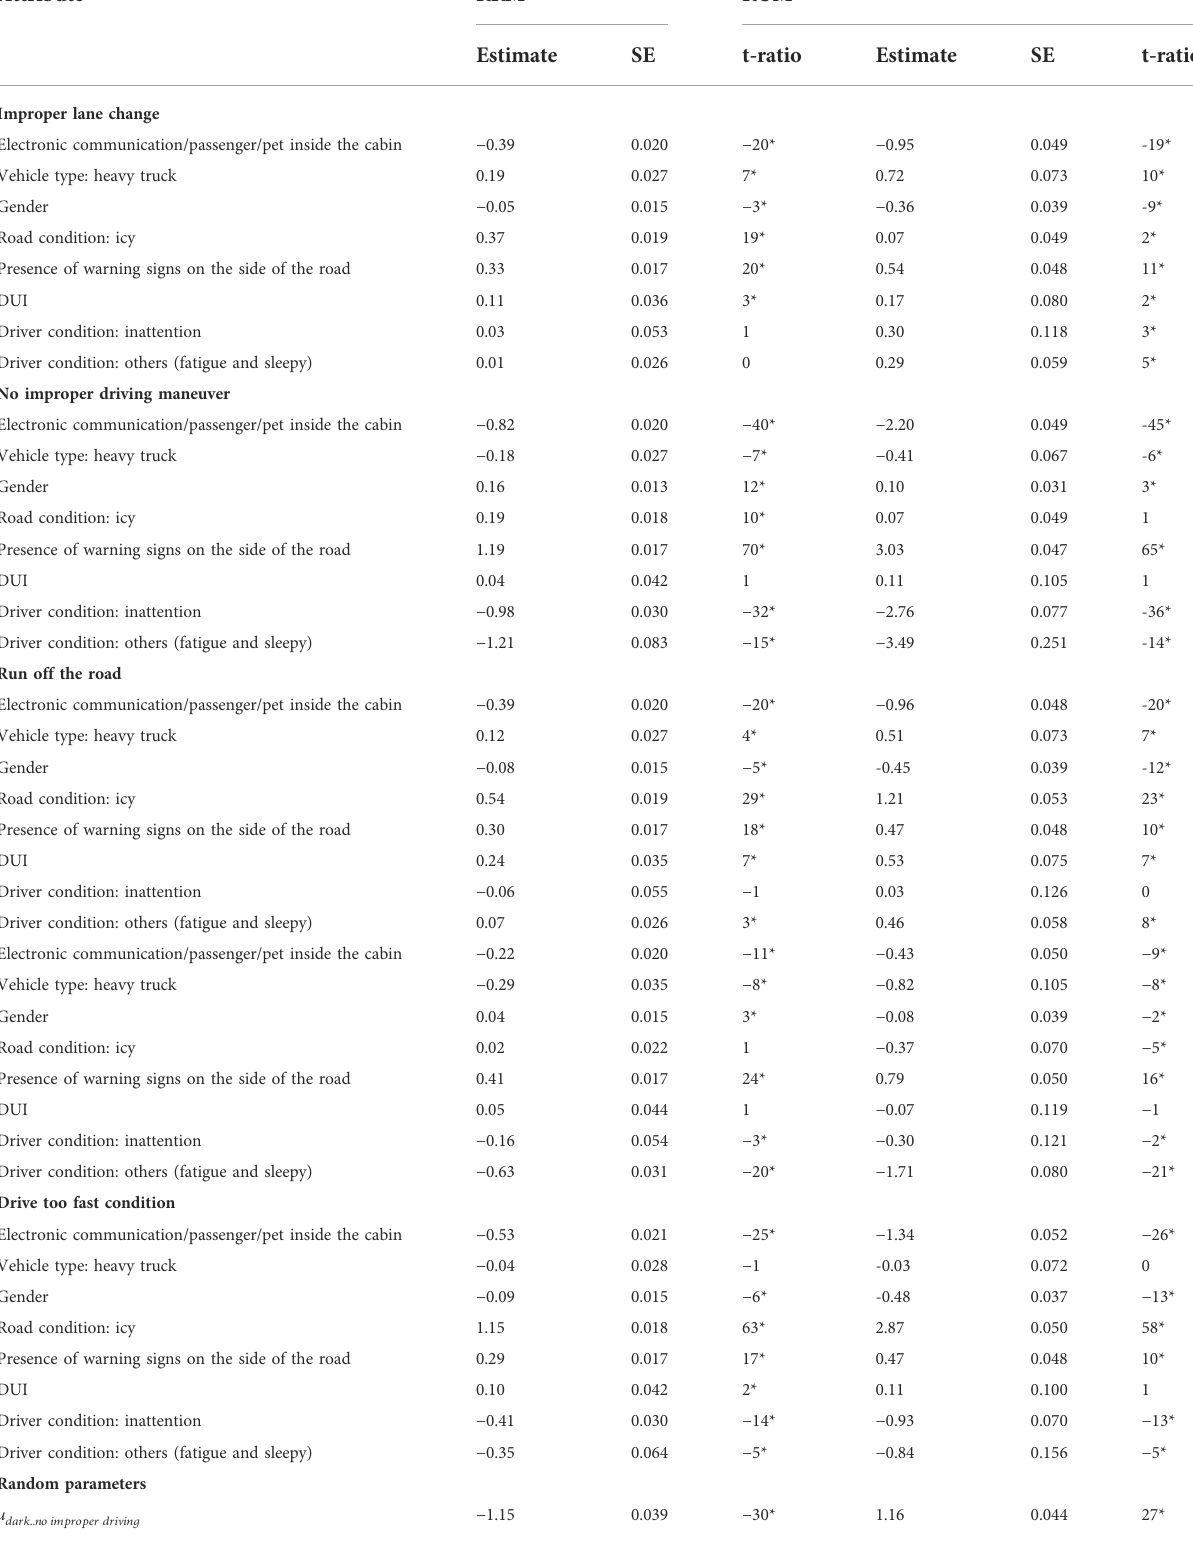
TABLE 3 Estimation results of RRM and RUM. Attribute RRM RUM Estimate SE t-ratio Estimate SE